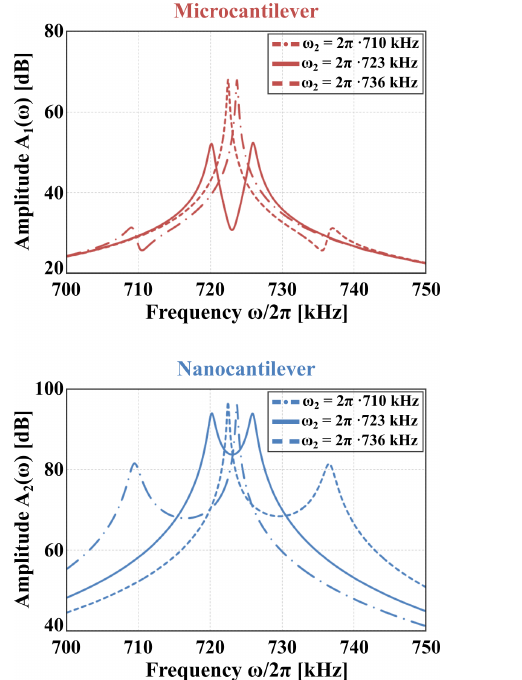
Figure 10. Bode plot of amplitude curves for both cantilevers of the coupled system from Fig. 7 for varying ω 2 = 2 πf 2